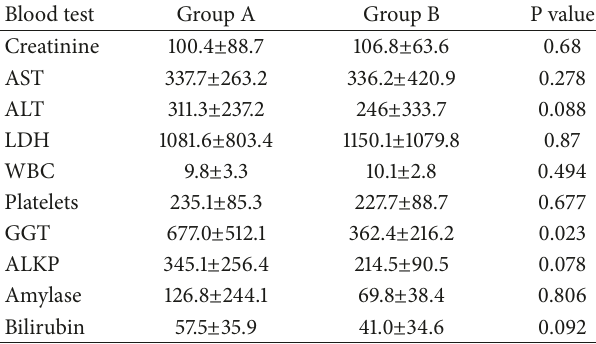
Table 3: Comparison of blood tests at admission: groups A and